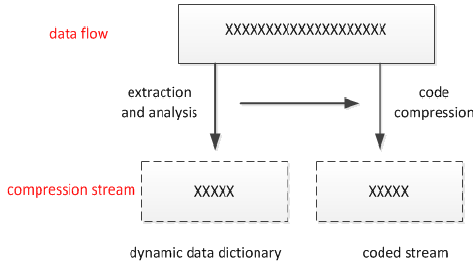
Figure 4 LZW compression algorithm